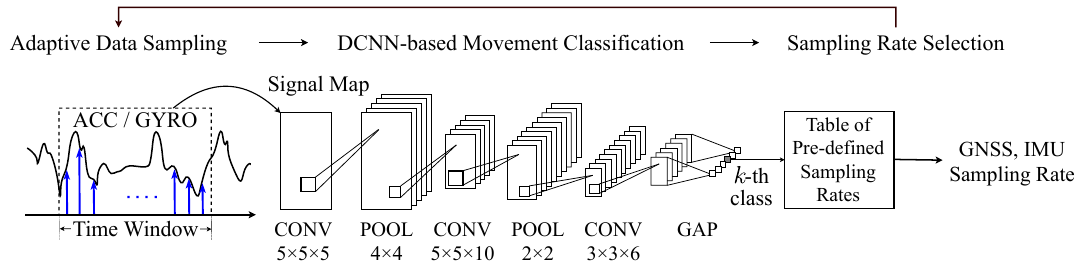
Figure 7. Processing sequence of the proposed DCNN-based sensor control